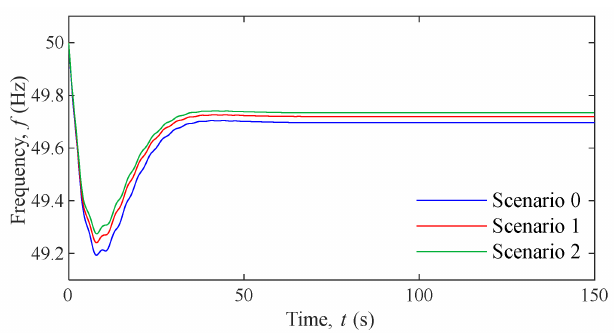
Figure 11. Frequency response after inserting a frequency disturbance of ∆ P = 1300 MW at t = 0 s with a total kinetic energy of 159 GW.s.